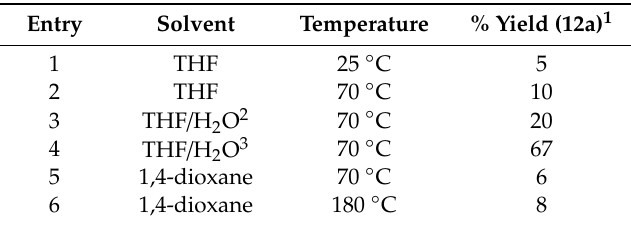
Table 2. Reactions for Suzuki–Miyaura cross coupling of